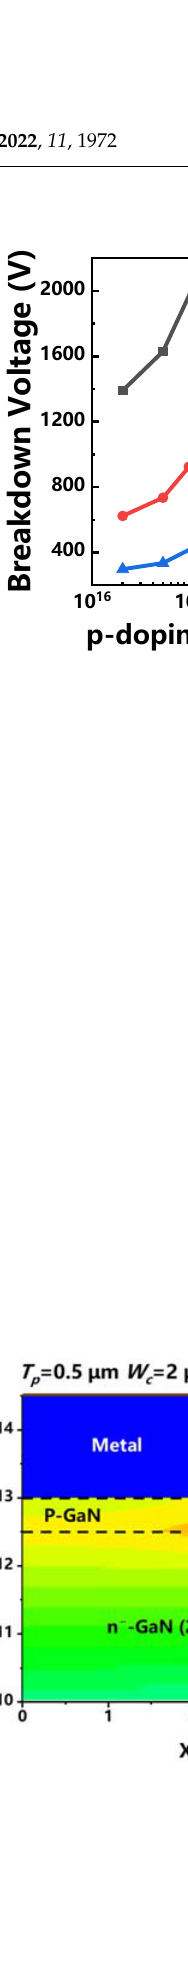
Figure 4. Local 2-D electric field distributions of TJBS diodes with p-doping concentrations of ( a ) 2 × 10 16 cm − 3 ; ( b ) 2 × 10 17 cm − 3 ; ( c ) 2 × 10 18 cm − 3 ; and ( d ) 2 × 10 19 cm − 3 at 600 V reverse biased and a drift layer concentration of 2 × 10 16 cm − 3 . In addition to the doping concentration, the thickness of the p-GaN structure also plays a crucial role in the reverse characteristics of the TJBS diodes, as illustrated in Figure 5a. A stronger correlation between the breakdown voltage and the p-GaN thickness can be observed with a lower p-doping concentration. Specifically, with a p-doping concentration of 2 × 10 16 cm − 3 , the breakdown voltage of the TJBS diodes increases monotonously with the p-GaN thickness. By increasing the p-doping concentration to 2 × 10 17 cm − 3 , the breakdown voltage experiences a sharp increase with the p-GaN thickness before reaching a saturation at a p-GaN thickness of 0.4 μ m. The breakdown voltage of the TJBS diodes remains constant with the p-GaN thickness when the p-doping concentration exceeds 2 × 10 18 cm − 3 .